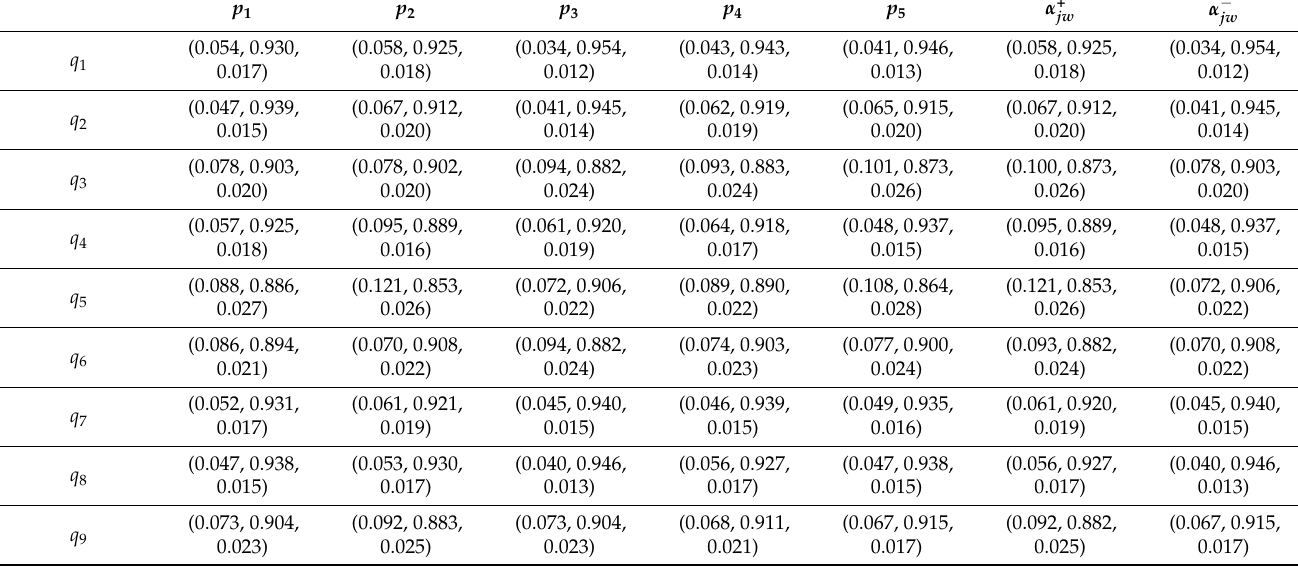
Table A6. The weighted normalized AIF-DM of each option for prioritizing the